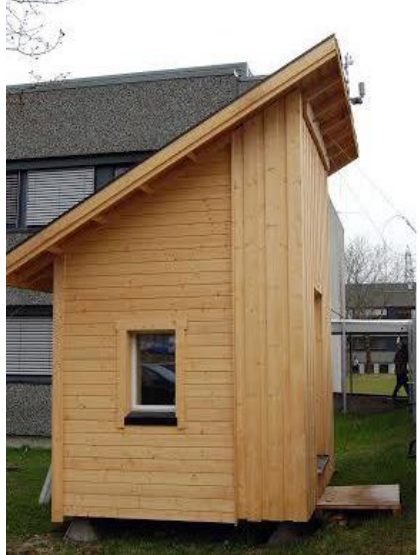
Figure 2. An image of the test building from the east direction.